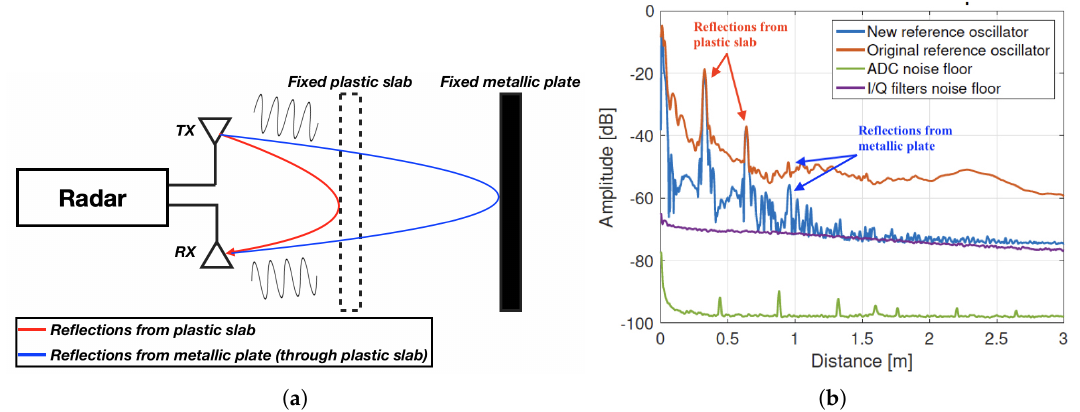
Figure 6. ( a ) Diagram of the measurement set-up for spectral noise characterization, where the radar aims at two targets in its line of sight: a penetrable plastic slab, and a metallic plate behind it. ( b ) Spectral comparison among different stages of the radar’s